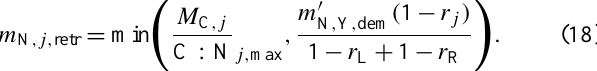
ter pressure at saturation ( (cid:57) s ), volumetric water content at saturation ( θ s ) and a shape parameter describing the response of the water retention curve to changes in water content ( b